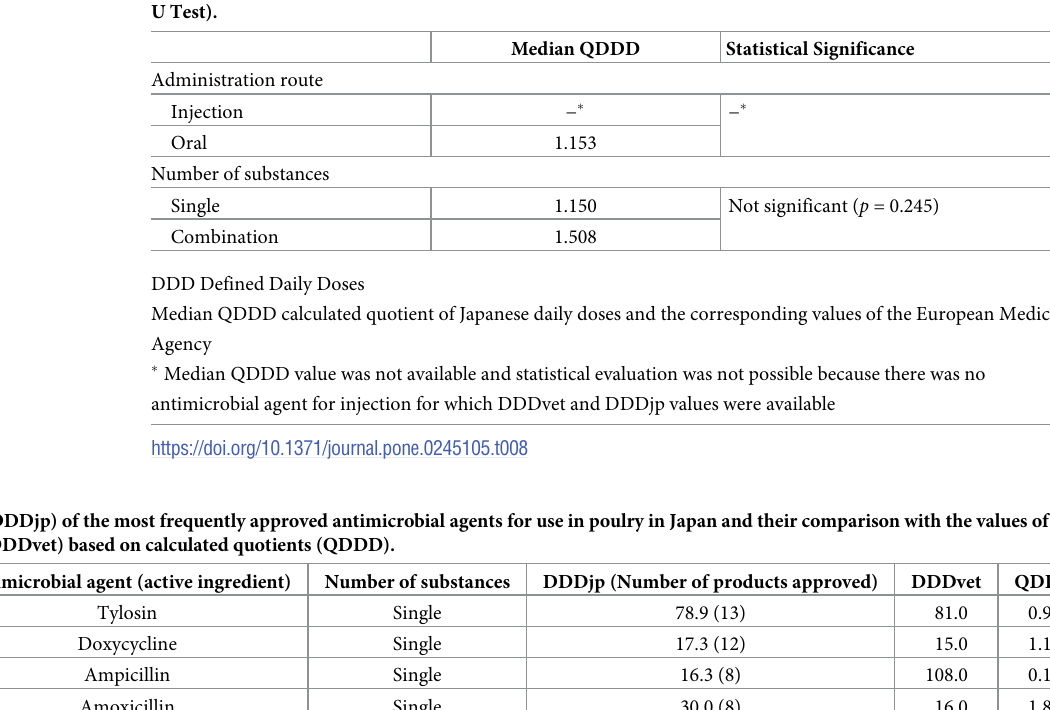
A comparison of DDDjps and DDDvet for antimicrobials destined for intramammary administration was not made in our study, because DDDvet values were not available in mg/ kg/day. The DDDjp values for these antimicrobials were assigned in mg/kg/day assuming a